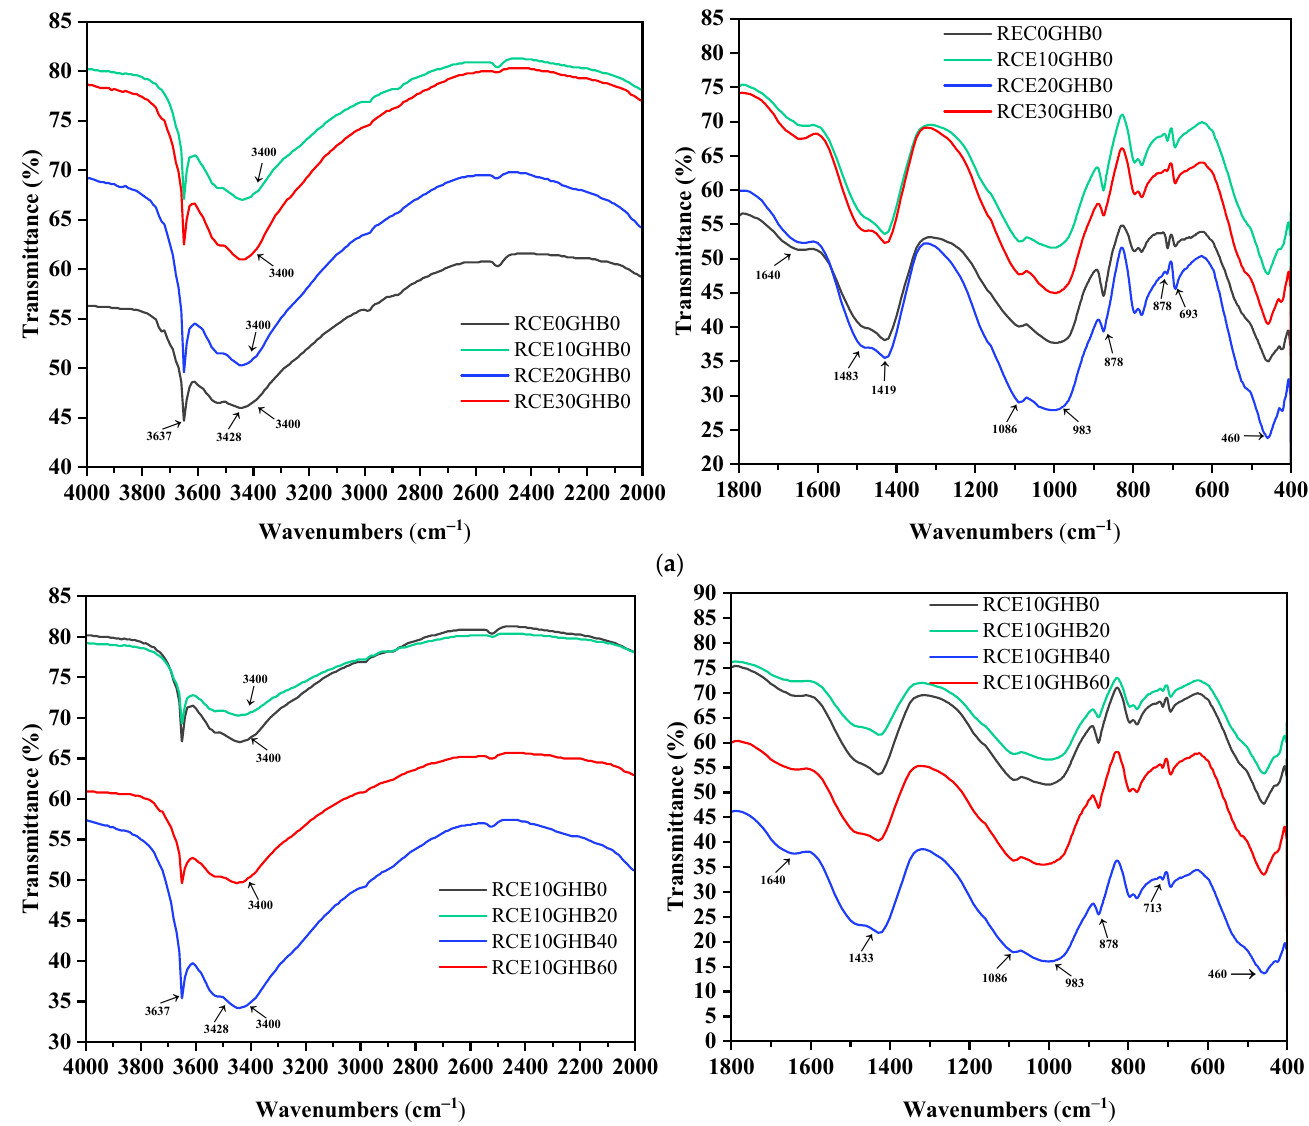
Figure 13. The effect of RCE and GHB on the functional groups of concrete hydration products. ( a ) The functional groups of RTIC (RCE0GHB0, RCE10GHB0, RCE20GHB0, RCE30GHB0); ( b ) the functional groups of RTIC (RCE10GHB0, RCE10GHB20, RCE10GHB40, RCE10GHB60).